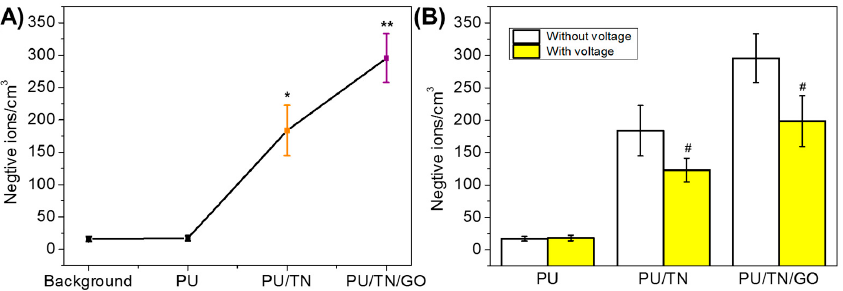
Figure 6. Negative ions releasing performances of PU and its nanocomposite fibers: ( A ) in the common environment and ( B ) the effect of voltage on negative ions releasing; *, significant difference compared to neat PU; **, significant difference compared to PU/TN and #, significant difference compared to itself without voltage, p < 0.05.